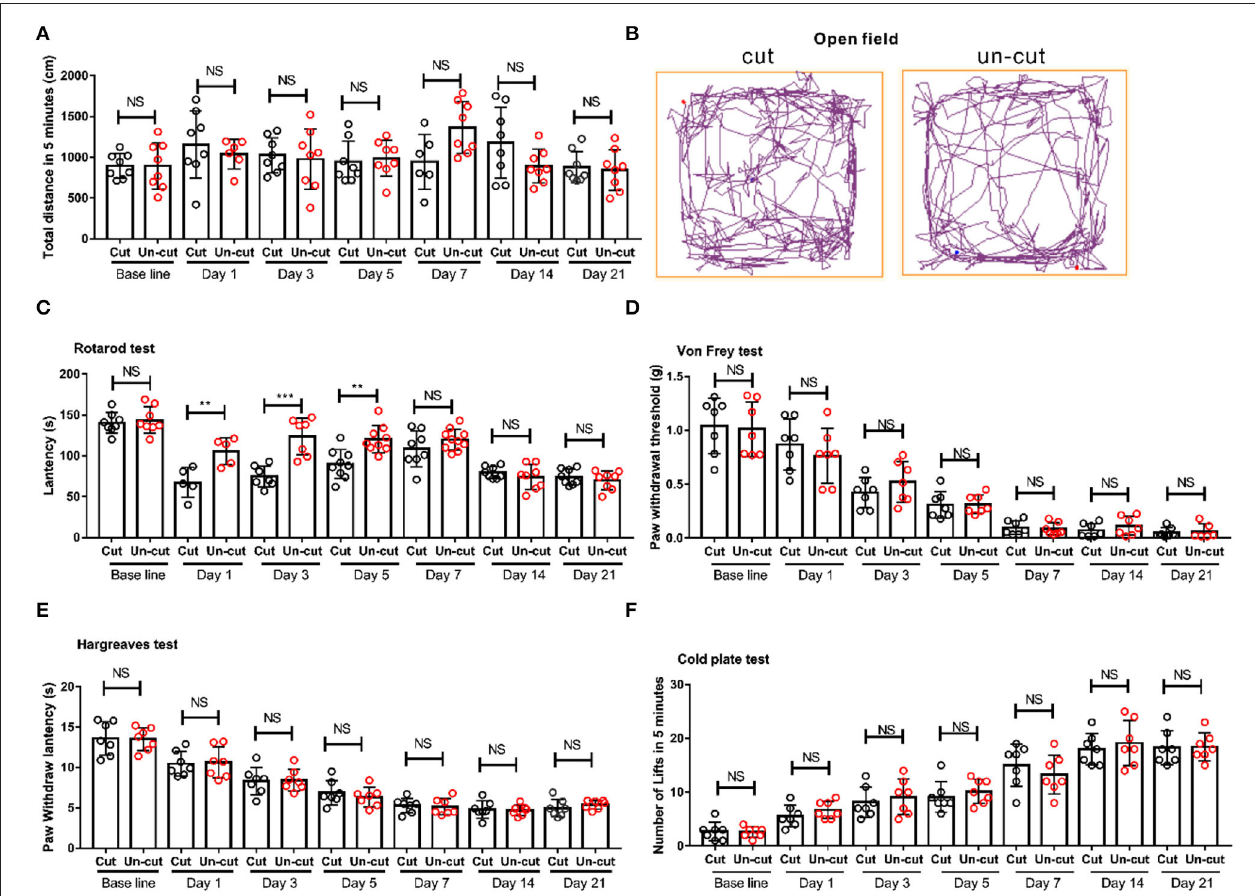
FIGURE 3 | The behavioral difference in outcomes between severing or maintaining the patellar ligament. (A) The motion distance compared between patellar ligament cutting off and patellar ligament uncutting off group on the base line, 1st, 3rd, 5th, 7th, 14th, and 21st day. n = 8 mice/group. (B) Representative pictures show movement track of mice within 5 mins in patellar ligament cutting off and patellar ligament un-cutting off group in the open field tests on the 21st day after CIBP surgery. (C) The latency in rotarod tests of the two groups on base line, 1st, 3rd, 5th, 7th, 14th, and 21st day. n = 8 mice/group. (D) Von-Frey test results of the two groups, n = 7 mice/group. (E) Thermal radiation test results of the two groups, n = 7 mice/group. (F) Cold plate test results of the two groups, n = 7 mice/group. ** P < 0.01, *** P < 0.001 by two-way (A,E) repeated measures ANOVA followed by post-hoc